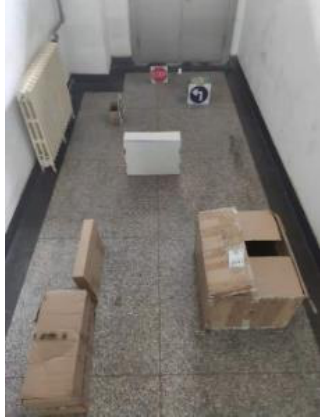
Figure 18. Experimental Environment.